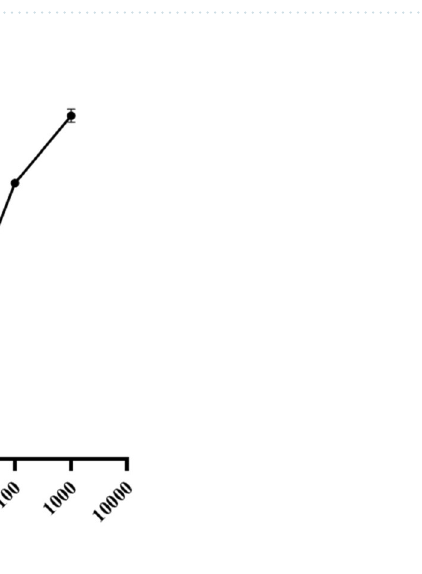
Figure 7. Dose response curves for GCSF derivatives on NFS-60 cells. Data are given as mean ± SD values of triplicate wells.